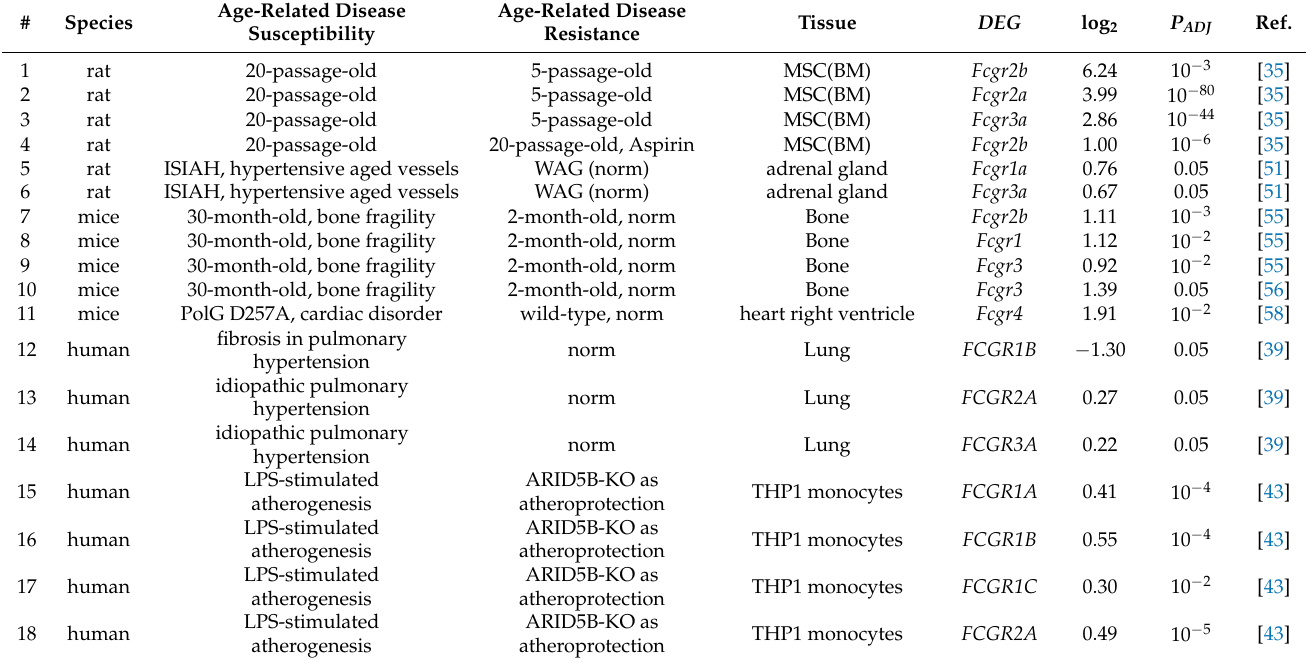
Table 7. Statistically significant data on upregulation of Fc γ -receptor-IIb-related DEGs linked to ARD susceptibility and ARD resistance in the subject